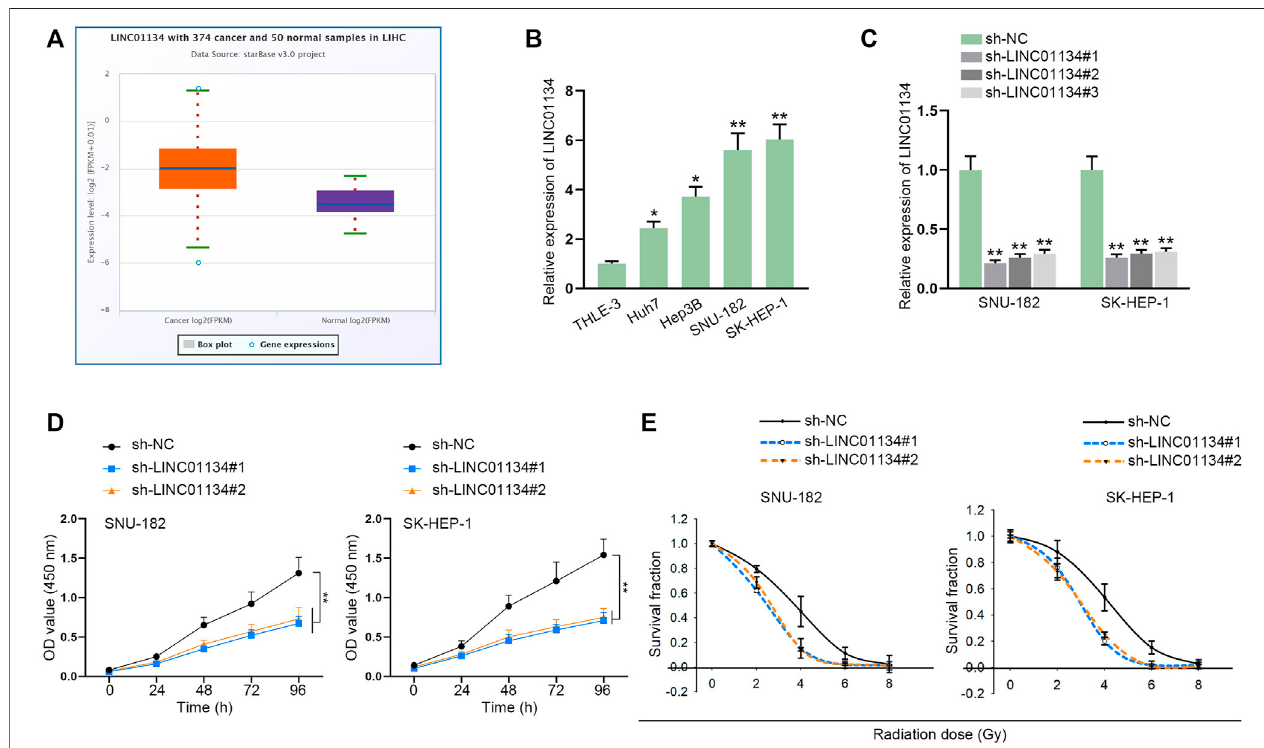
FIGURE 1 | LINC01134 is highly expressed in HCC, and LINC01134 depletion weakens the viability of HCC cells. (A) StarBase website was used to search for LINC01134 expression in HCC tumor samples and normal samples. (B) RT-qPCR examined LINC01134 expression in HCC cells and normal cells (THLE-3). (C) The knockdownef fi ciencyofsh-LINC01134#1/2/3wasevaluatedbyRT-qPCRinHCCcells. (D) Thein fl uenceofLINC01134depletiononHCCcellviabilitywasevaluatedby a CCK-8 assay. (E) With exposure to radiation of 0 Gy, 2 Gy, 4 Gy, 6 Gy, and 8 Gy, colony formation assay was performed to estimate survival fractionation when LINC01134 was inhibited in HCC cells. * p < 0.05, ** p <